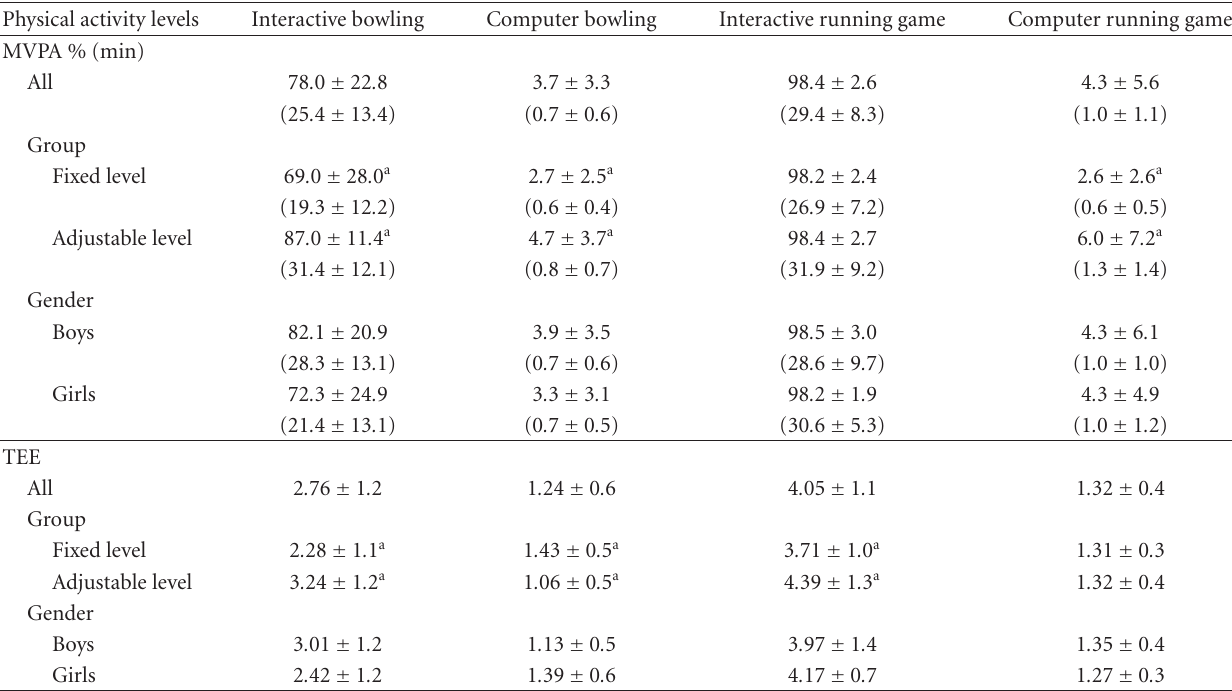
Table 3: Children’s overall mean MVPA% ± SD (actual min ± SD) and TEE by game type and mode. Physical activity